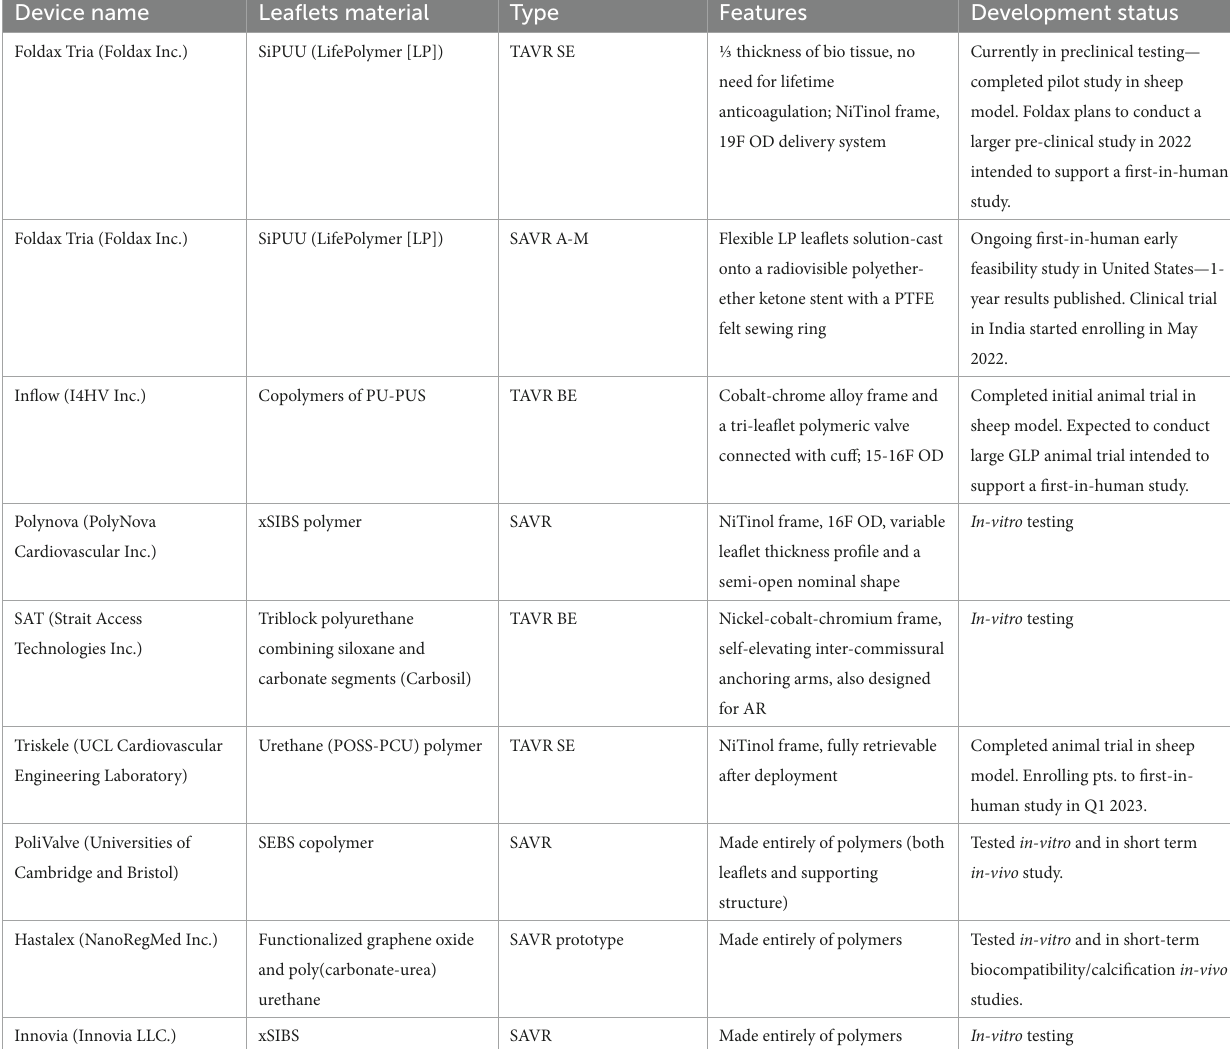
TABLE 1 Description of various polymer valves, leaflet material, unique structural leaflets, and current status of